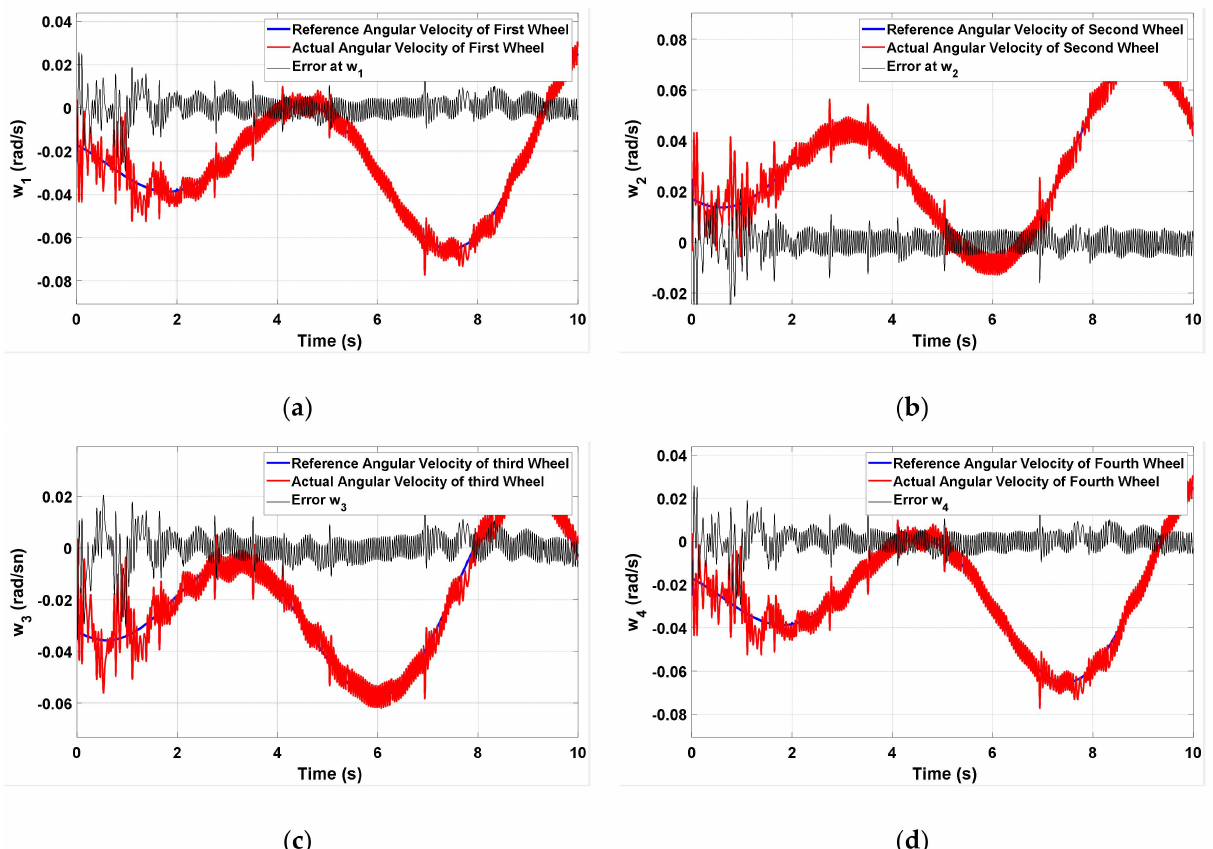
Figure 10. The comparison of reference and actual angular velocities (blue line: reference angular velocity, red line: actual angular velocity and black line: error between reference and actual